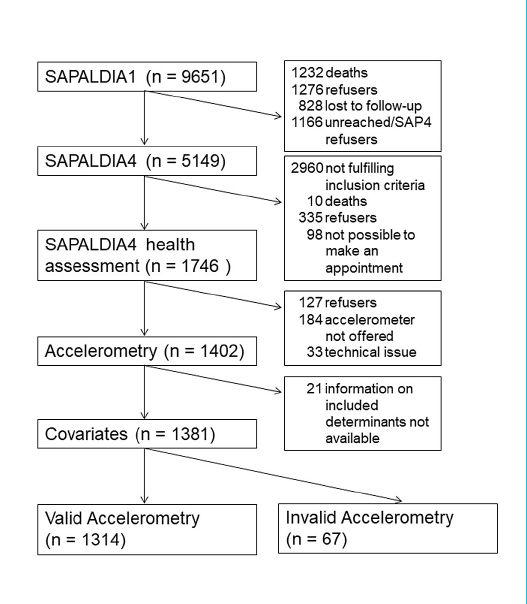
Figure 1: Participation from SAPALDIA1 to the current accelerom- etry study among participants aged 52+ at SAPALDIA4 (1991–2018).